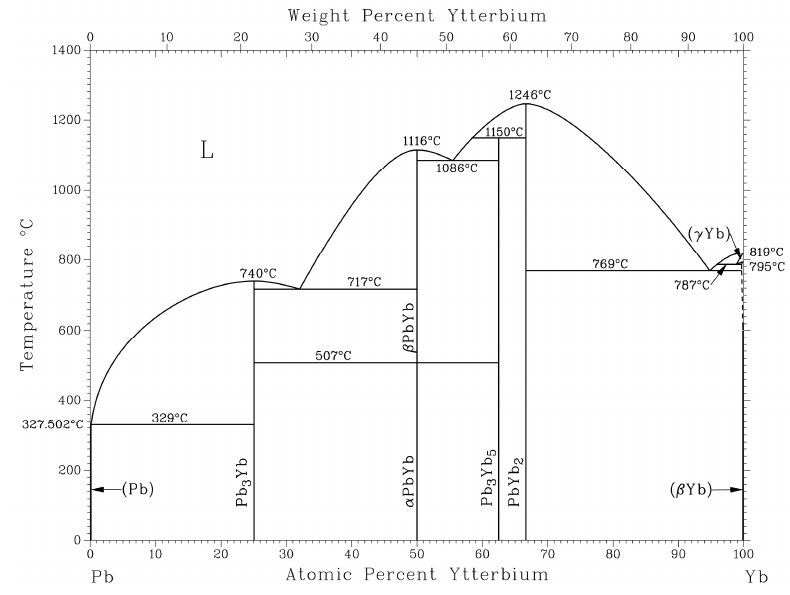
Figure 7. The binary phase diagram of the Pb-Yb system. To confirm the attribution of the peaks, Figure 8 shows the SWV curves at different frequencies on the W electrode in molten LiCl-KCl-YbCl 3 -PbCl 2 . Six reductive peaks were observed clearly in Figure 8. Two reduction signals R B and R C pertain to the reduction of Yb(III) to Yb(II) and Pb(II) to Pb, respectively. Four reduction peaks R I , R II , R III , and R IV are associated with four Pb-Yb intermetallics. The reduction peak potentials are listed in